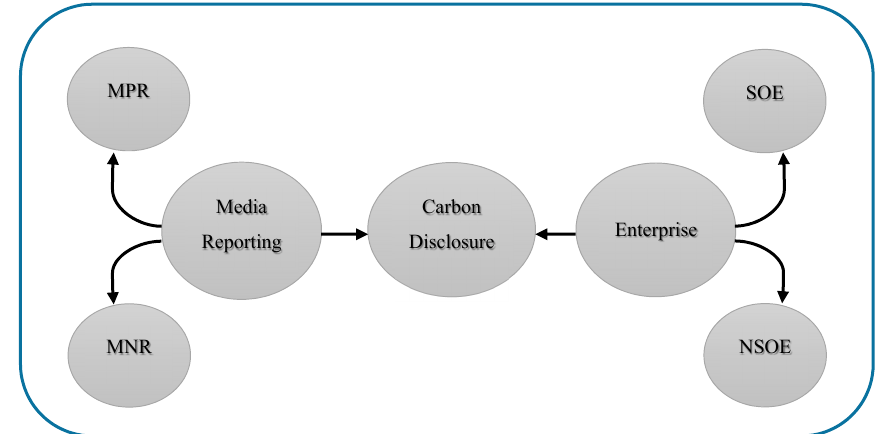
Figure 1. Interaction between enterprises’ carbon disclosure information and media reporting. Acronyms: MediaPositiveReporting(MPR);MediaNegativeReporting(MNR);State-OwnedEnterprise (SOE); Non-State-owned Enterprise